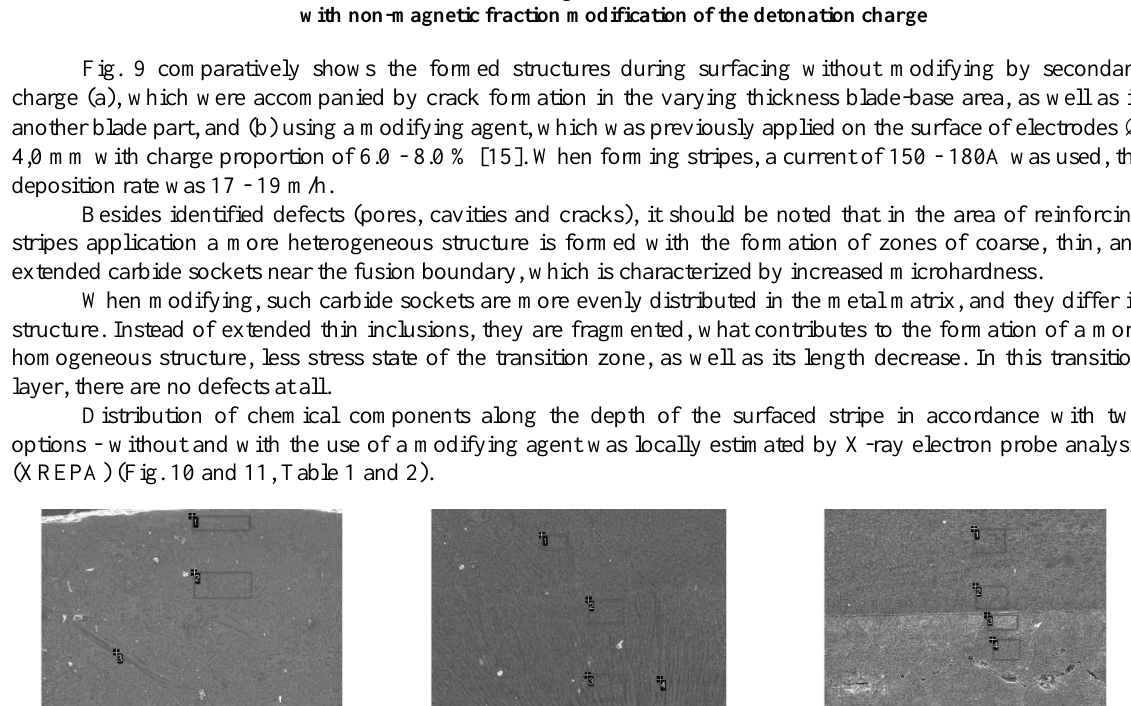
a - surfacing surface; b - middle; c - heat-affected